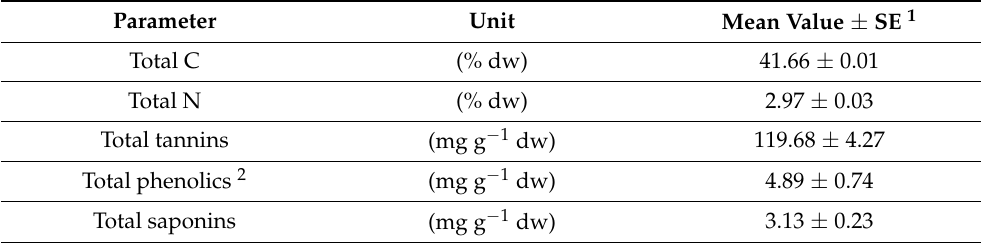
Table 1. Composition of the experimental biomass of Hedysarum coronarium